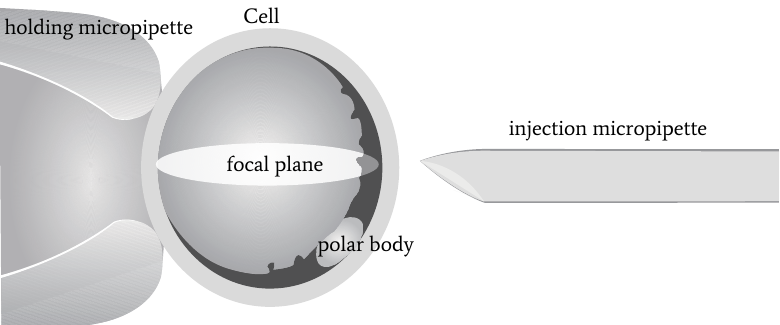
Figure 1. Three-dimensional illustration of oocyte rotation.